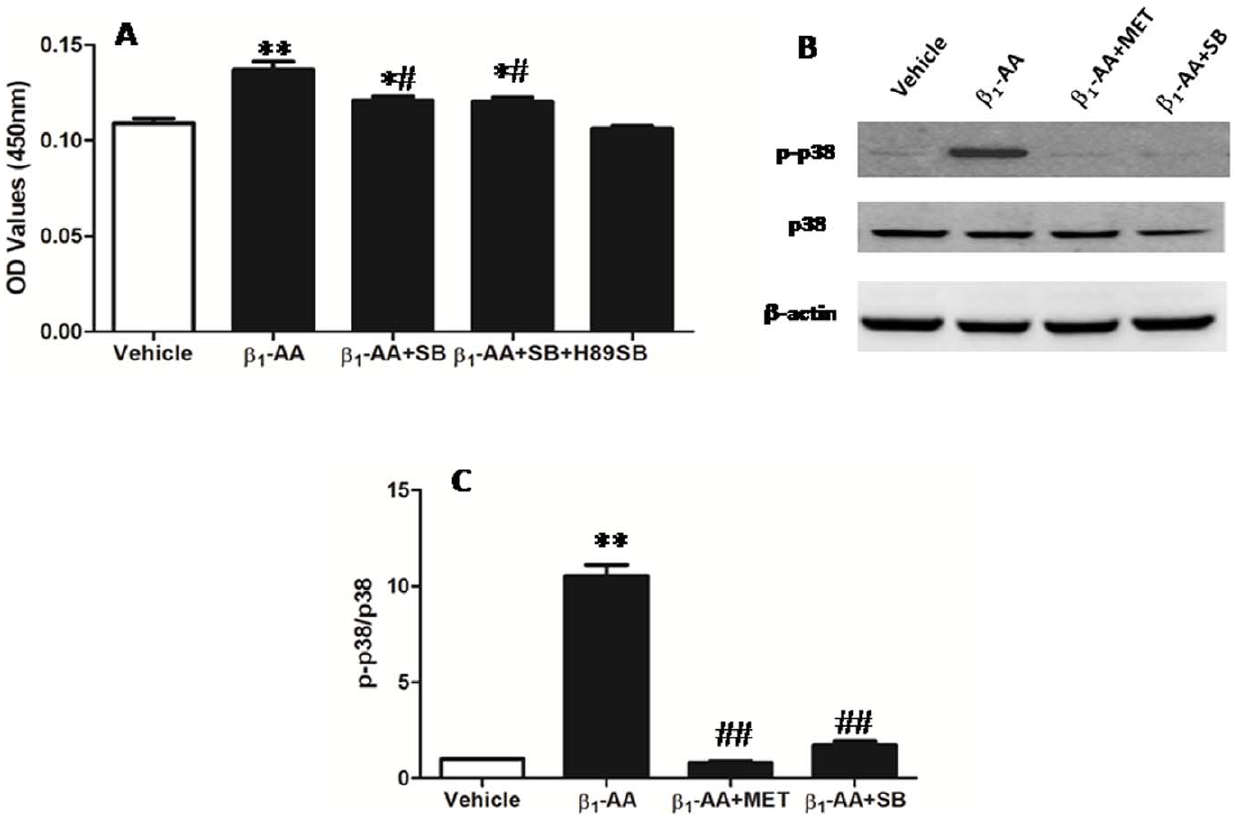
Figure 6. b 1 -AA-mediated T cell proliferation mediated by activation of p38 MAPK. A. T cells were pretreated with the selective PKA inhibitor H89 (1 m mol/l) and the selective p38 MAPK inhibitor SB203580 (1 m mol/l) for 1 h at 37 u C in 5% CO 2 before stimulation by b 1 -AA (25 m g/ml). * p , 0.05, ** p , 0.01 versus vehicle group; # p , 0.05 versus b 1 -AA group. n =9 per group. B. Immunoblot detection of phosphorylated p38 MAPK (p- p38 MAPK) and total p38 MAPK from CD3 + T cells stimulated with b 1 -AA for 30 min. Images are representative of three independent experiments. C. The bar graph shows the ratio of p-p38 MAPK to total p38 MAPK. n =3, ** p , 0.01 versus Vehicle group, DD p , 0.01 versus b 1 -AA group, SB: SB203580.